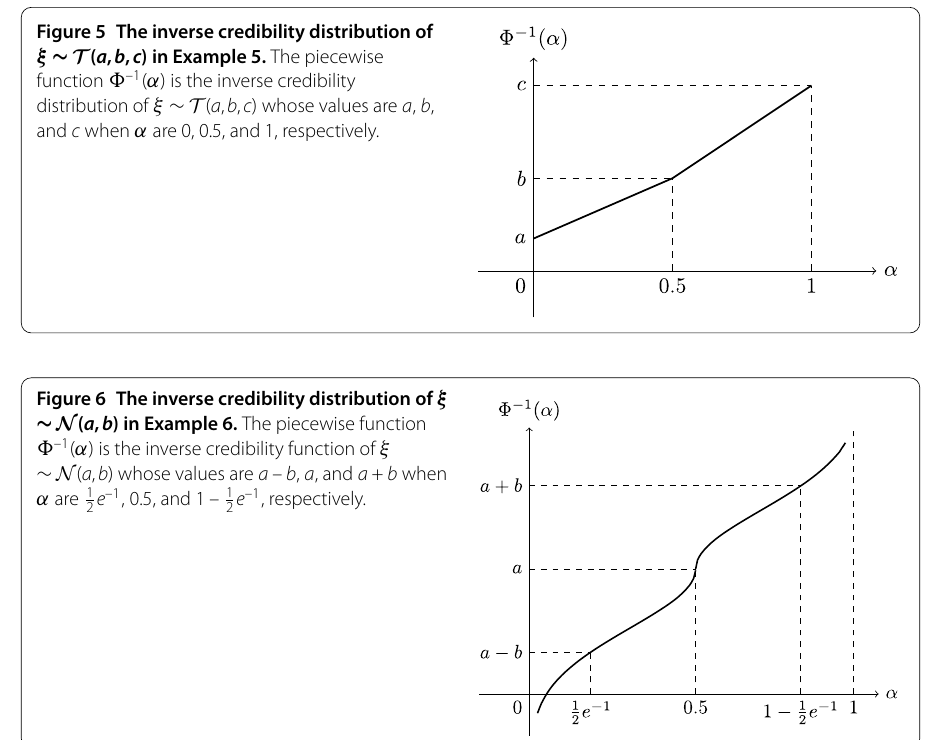
Figure 5 The inverse credibility distribution of ξ ∼ T ( a , b , c ) in Example 5. The piecewise function (cid:5) –1 ( α ) is the inverse credibility distribution of ξ ∼ T ( a , b , c ) whose values are a , b , and c when α are 0, 0.5, and 1, respectively.